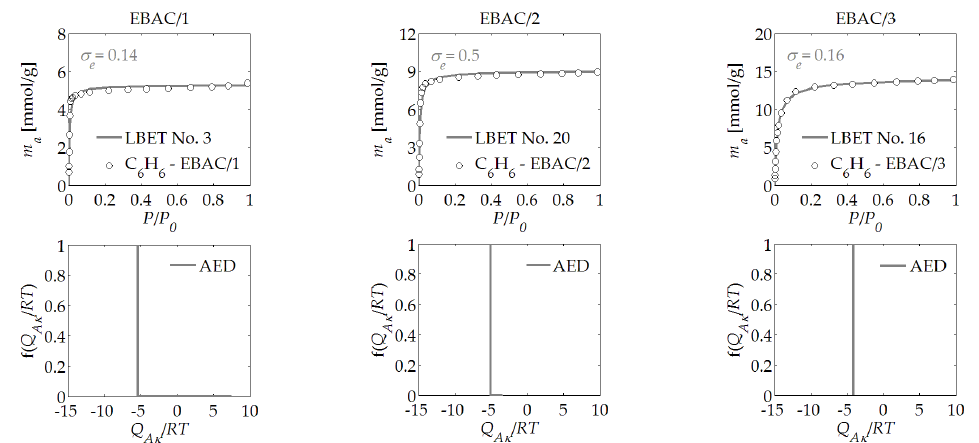
Figure 1. The benzene adsorption isotherms and the results of the identification of the adsorption systems via the LBET method, and adsorption energy distributions (AEDs) obtained for the MAAC/ R active carbons, which were derived from mahogany wood.